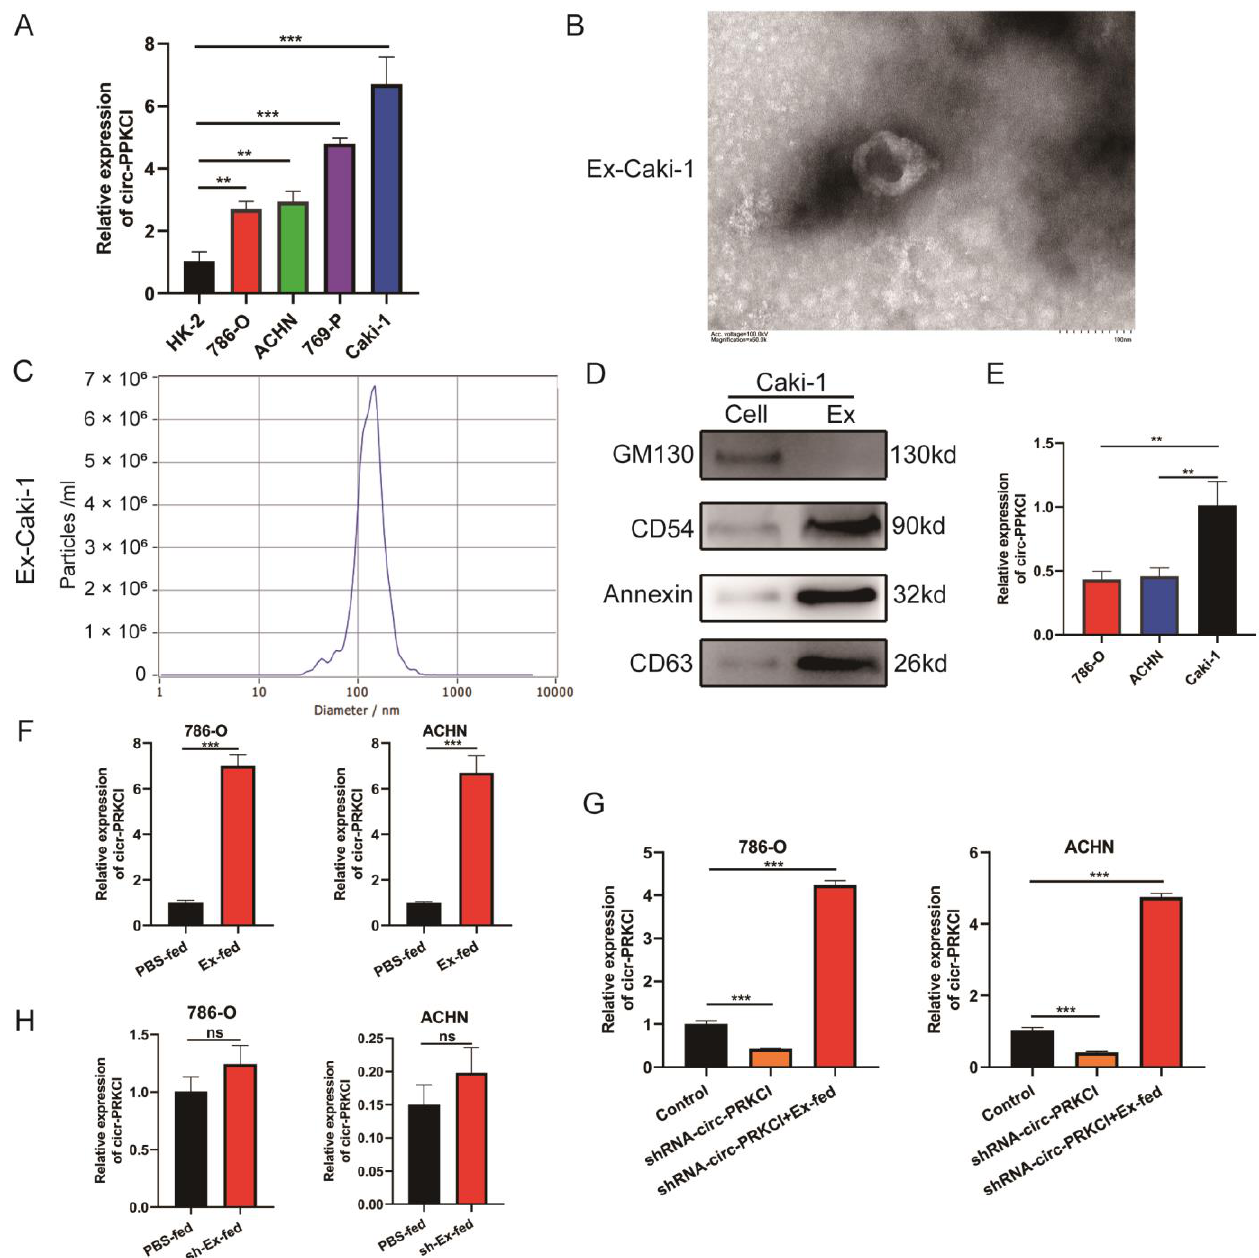
Figure 2. Intracellular transferring of circ-PRKCI in an exosome manner. ( A ) circ-PRKCI expression in RCC cell lines and HK-2 normal cells using qRT-PCR. ( B , C ) Exosomes were isolated from the supernatant of the culture medium of Caki-1 cells, and the morphology and size were detected by transmission electron microscopy (scale bar = 100 nm) and nanoparticle tracking analysis. ( D ) Protein expressions of exosomal markers GM130, CD54, Annexin, and CD63 in exosomes derived from the supernatant of the culture medium of Caki-1 cells and negative control Caki-1 cellular lysates. ( E ) circ-PRKCI expression in the exosomes derived from the supernatant of Caki-1, 786-O and ACHN cell cultures. ( F ) circ-PRKCI expression in 786-O and ACHN after being treated with exosomes derived from Caki-1. ( G ) circ-PRKCI expression in 786-O and ACHN after transfection with sh-NC or sh-circ-PRKCI either with or without the addition of Caki-1-derived. ( H ) circ-PRKCI expression in 786-O and ACHN after treatment with exosomes(sh-Ex) derived from the cell culture of sh-circ-PRKCI-Caki-1 cells. (** p < 0.01, *** p < 0.001, ns: no significance).